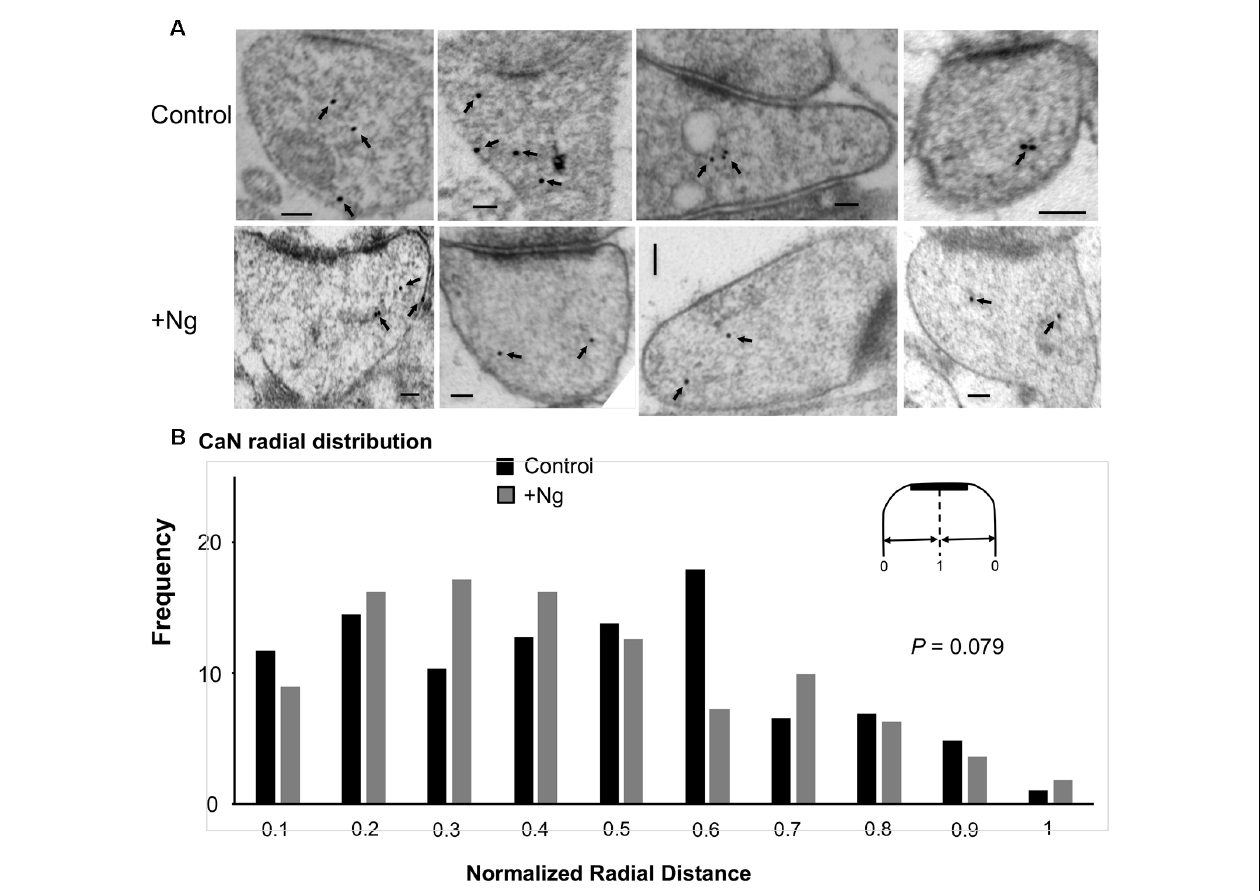
FIGURE 5 | Ng does not change the ultrastructural localization of calcineurin. (A) Representative micrographs of immunogold-EM for calcineurin in control (same as of Figure 4 ) and Ng-overexpressing neurons. Scale bar, 100 nm. (B) Frequency histogram of the normalized radial distance of calcineurin particles. Ng does not change calcineurin radial